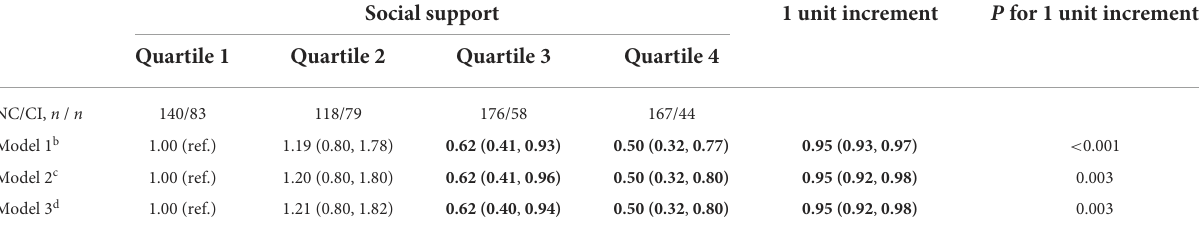
TABLE 5 Association between the social support and cognitive impairment in logistic regression.